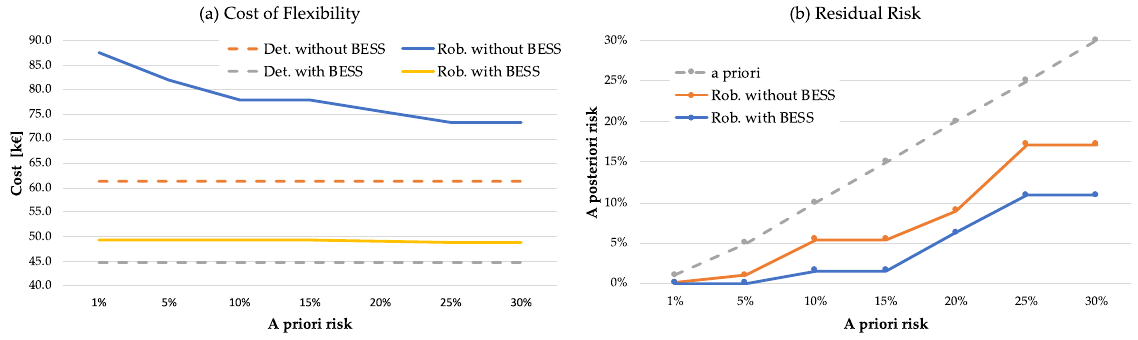
Figure 10. Comparison of the solutions in terms of flexibility cost ( a ) and residual risk ( b ).